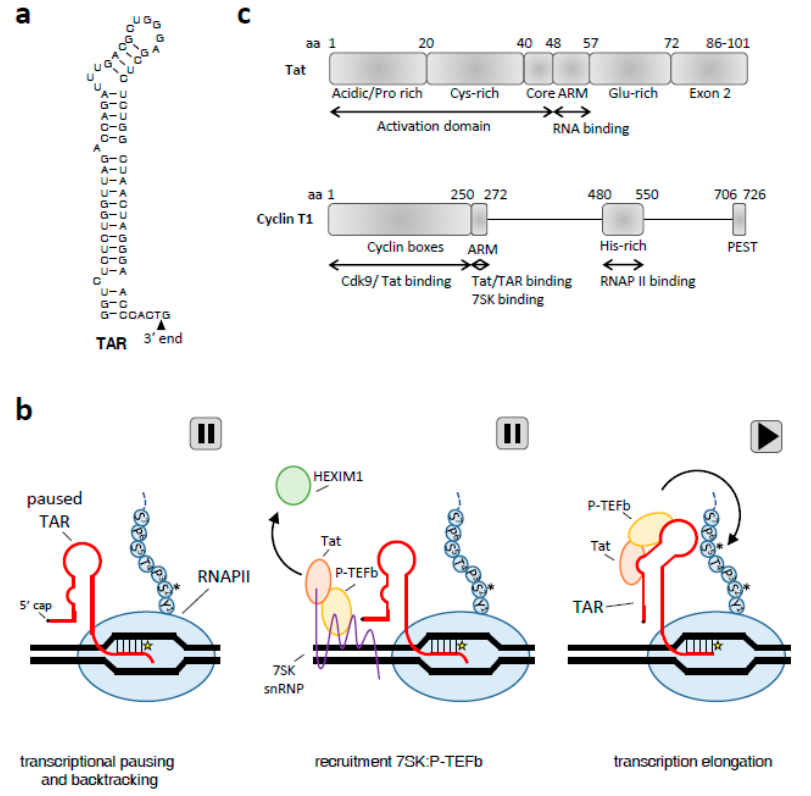
Figure 3. Factors involved in HIV-1 transcription and initiation. ( a ) Structure of the TAR hairpin; ( b ) model of RNAPII pausing (indicated with “II” button for pause) and reactivation (black triangle) upon TAR transcription. Phosphorylation of the CTD domain of RNAPII is indicated (black asterisk). The catalytic center of RNAPII is positioned at the yellow star. 7SK snRNA is depicted in purple. See the main text for more details; ( c ) domain organization of the viral Tat protein and positive transcription elongation factor b (P-TEFb) component Cyclin T1. Amino acid (aa) positions are indicated and the domain functions are described.